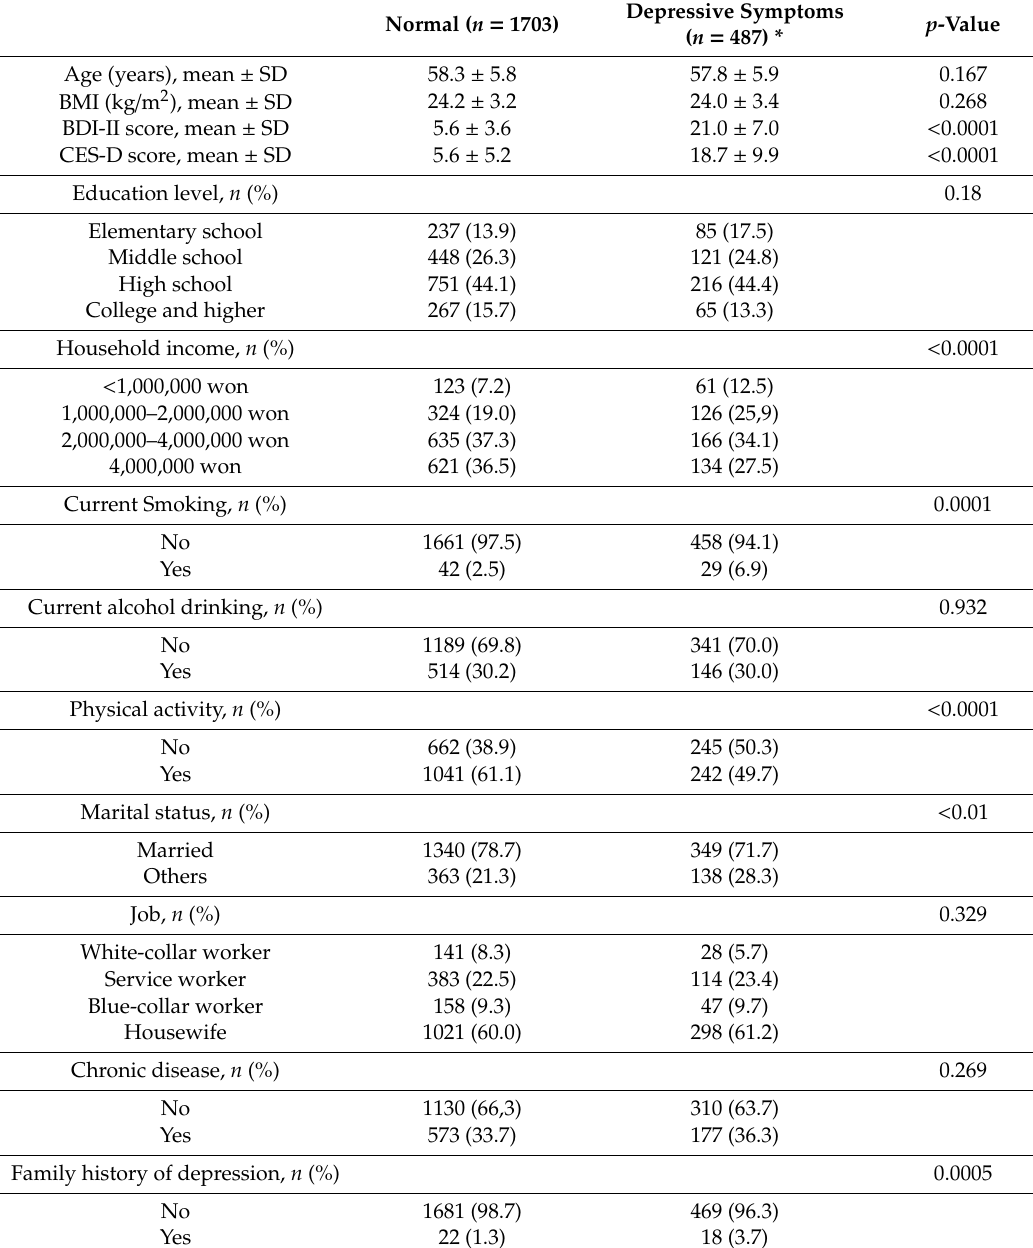
Table 1. Baseline characteristics of normal and depressive symptom